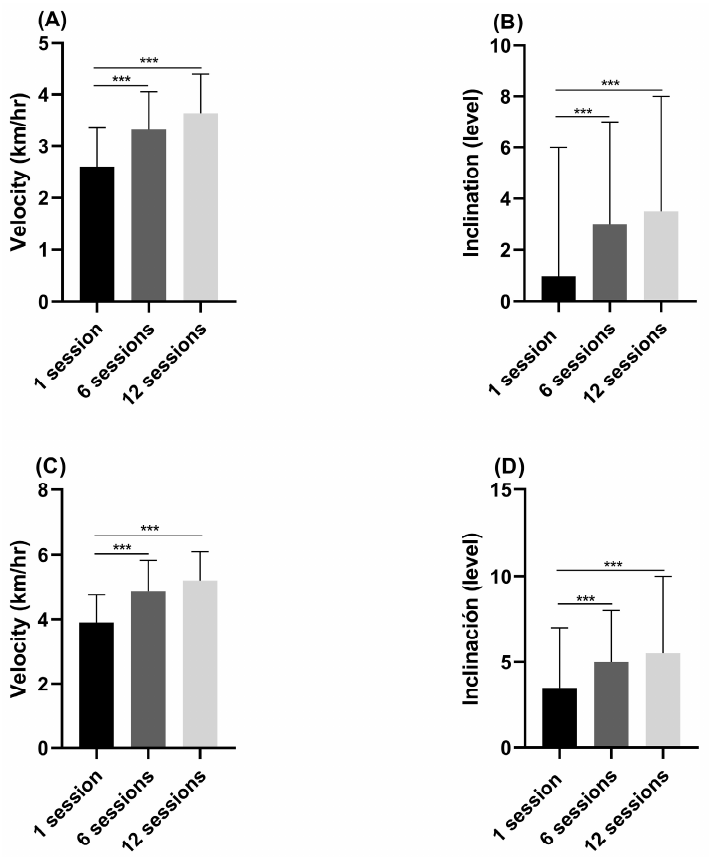
Figure 1. Workloads in pulmonary rehabilitation program sessions. ( A ) Low speed load; ( B ) low tilt